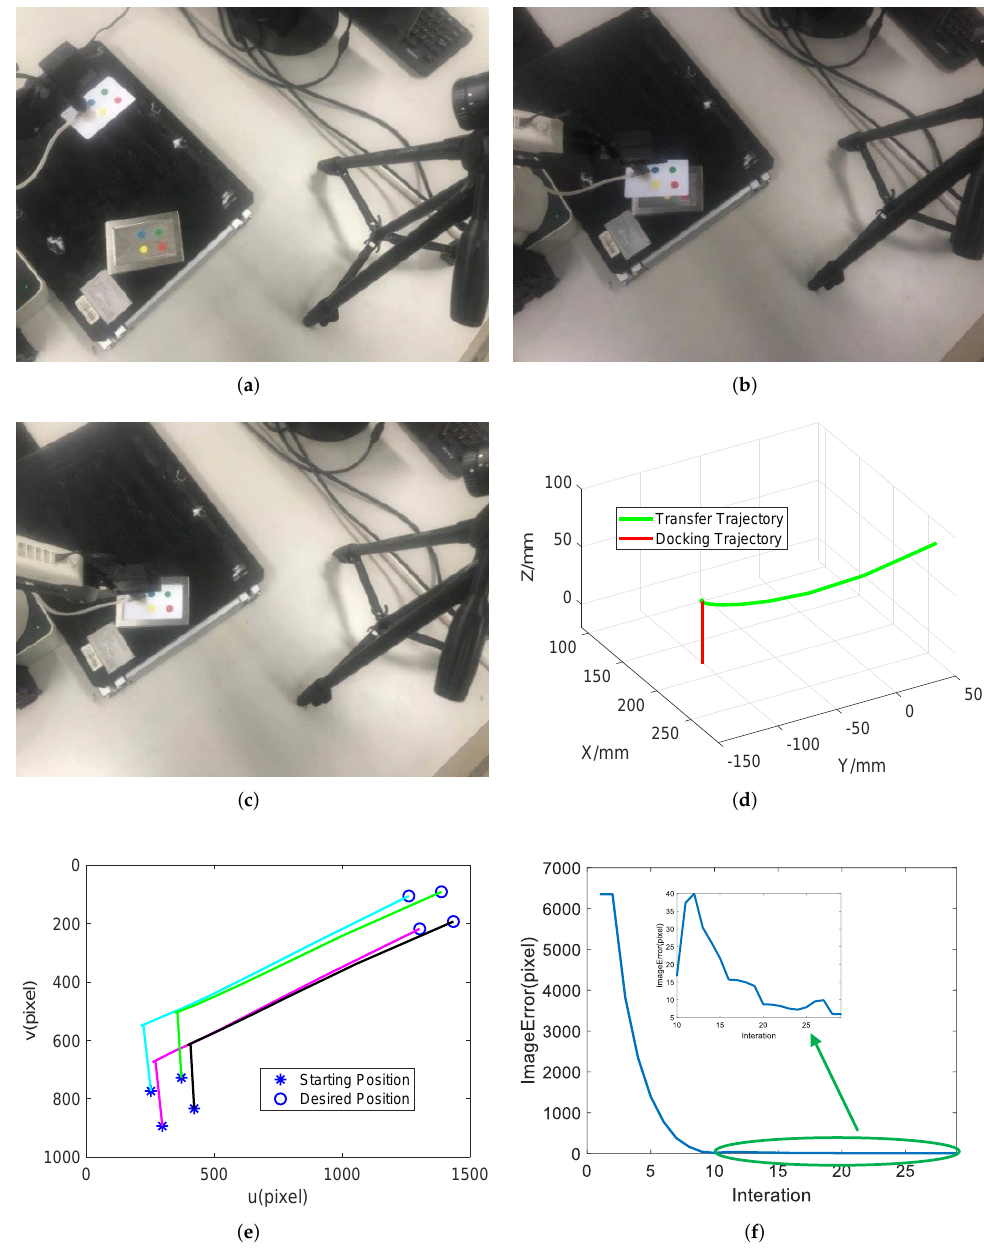
Figure 13. Experimental result of visual servoing control method based on perspective transformation: ( a ) Starting position of the robotic arm. ( b ) The robotic arm reached the assembly node. ( c ) The assembly task is accomplished. ( d ) Complete Spatial trajectory of the robotic arm. ( e ) Image trajectory. ( f ) Position error in the